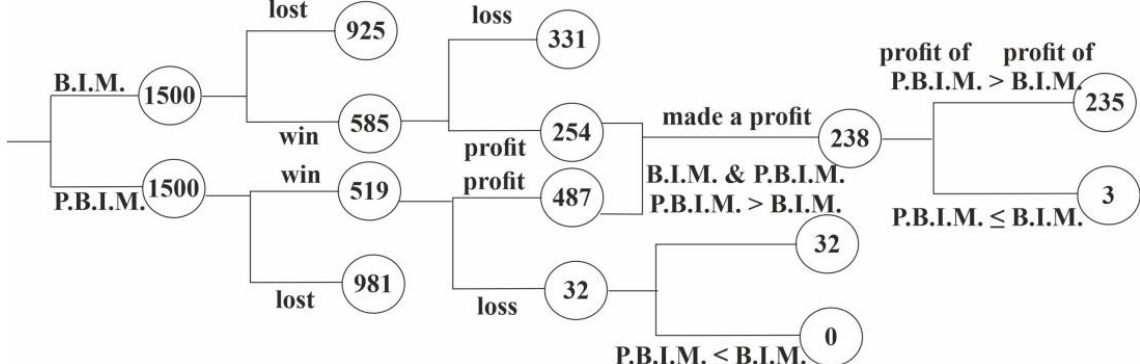
Figure 3. Results of the 1500 simulations.